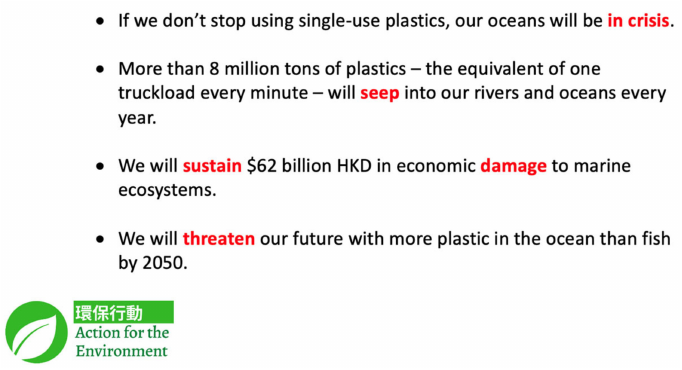
Figure A3. Example of condition 3: loss * text *